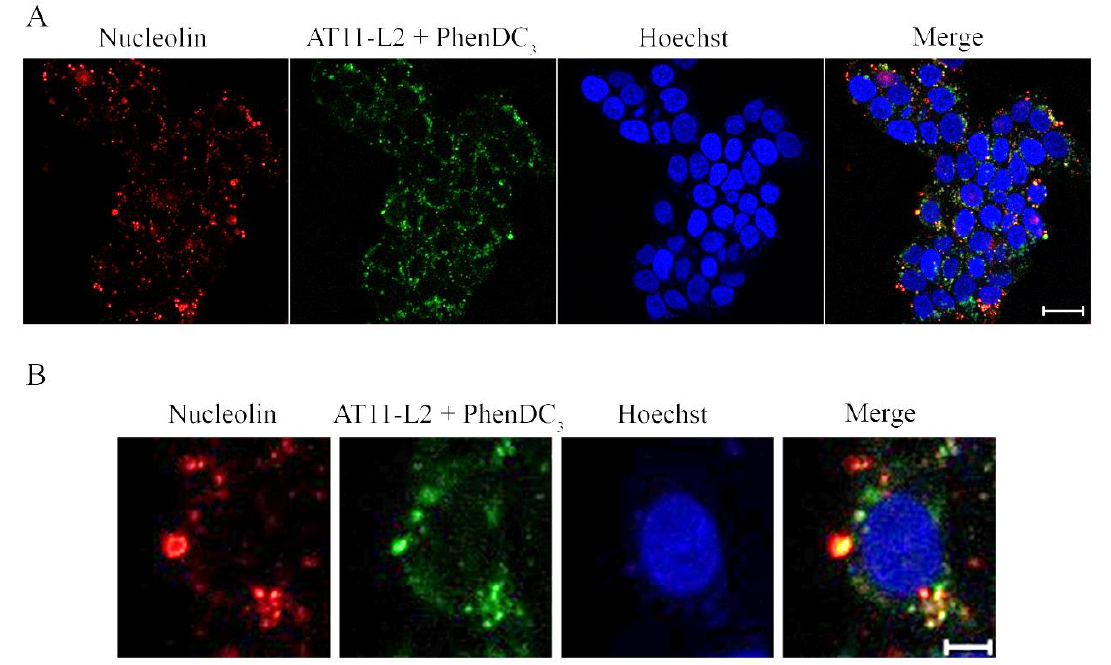
Figure 10. NCL immunofluorescence in UPCI-SCC-154 cells with 5´-FAM-AT11-L2-3´-TAMRA (green) conjugate with PhenDC3. The anti-NCL primary antibody was conjugated with an Alexa Fluor 647 secondary antibody (red) and nuclei were stained with Hoechst (blue). ( A ) Original images obtained with a 63× objective (scale bar: 20 µm). ( B ) Magnification from the original image (scale bar: 5 µm).